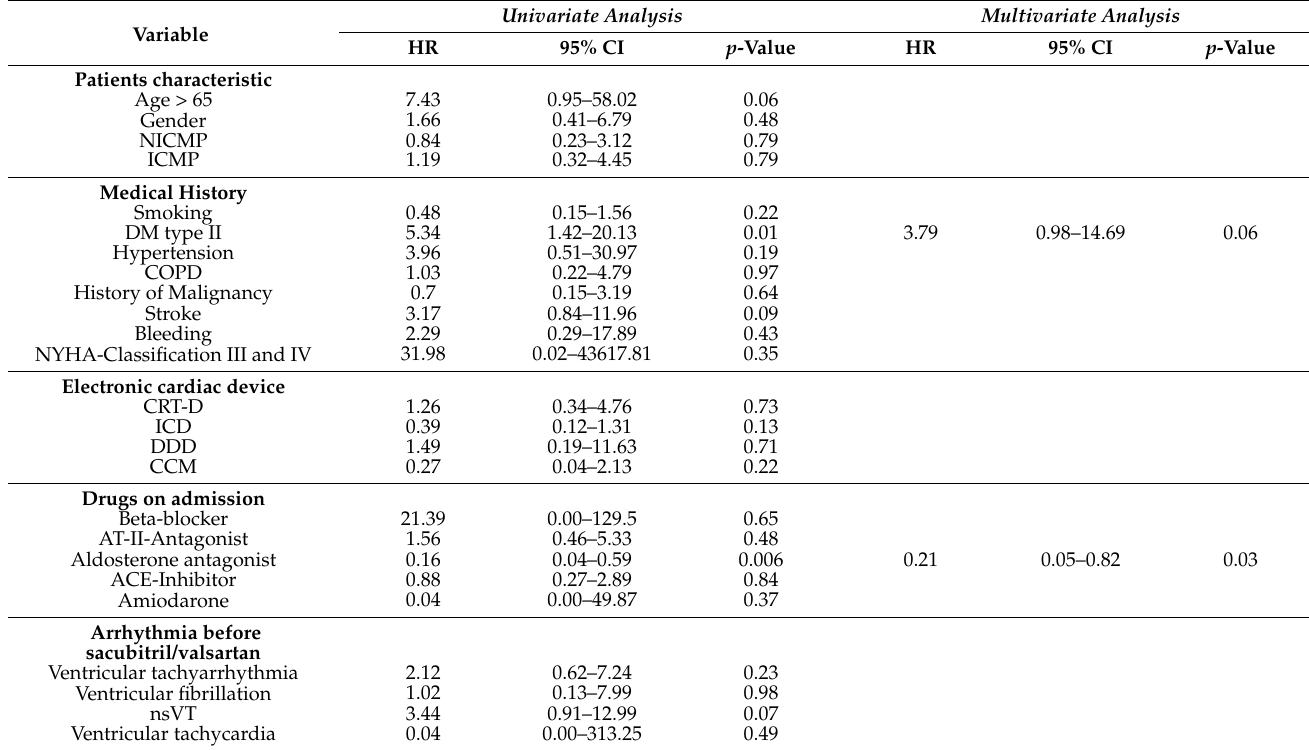
Table 4. Predictors for mortality .